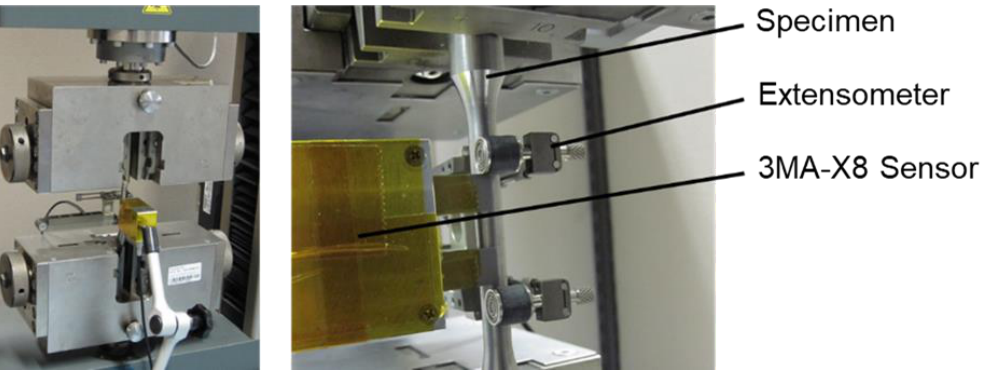
Figure 2. Measurement setup of a 3MA-X8 measurement of micromagnetic features during elastic tensile tests.